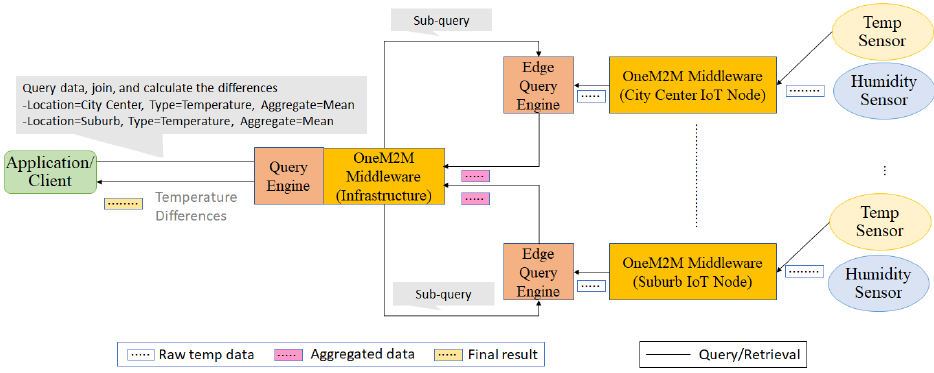
Figure 2. Our proposed query engine (QE) for better oneM2M data retrieval and